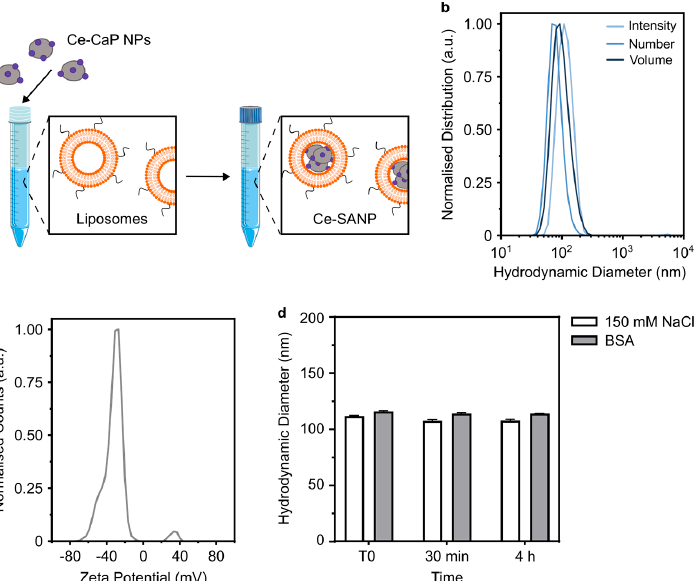
Figure 5. Physico-chemical characterization of Ce-SANP. ( a ) Schematic of the synthesis of Ce-SANP; the schematic was partly generated using Servier Medical Art, provided by Servier, licensed under a Creative Commons Attribution 3.0 unported license. ( b ) Normalized intensity (light blue), number (blue), and volume (dark blue) distributions of the Ce-SANP hydrodynamic diameter as measured by DLS. ( c ) Zeta potential measurement and ( d ) stability against aggregation at 37 °C of the Ce- SANP formulations following dilution in 150 mM NaCl or BSA. Data are represented as mean ± s.d. (N = 3 independent batches, n = 3 technical replicates).